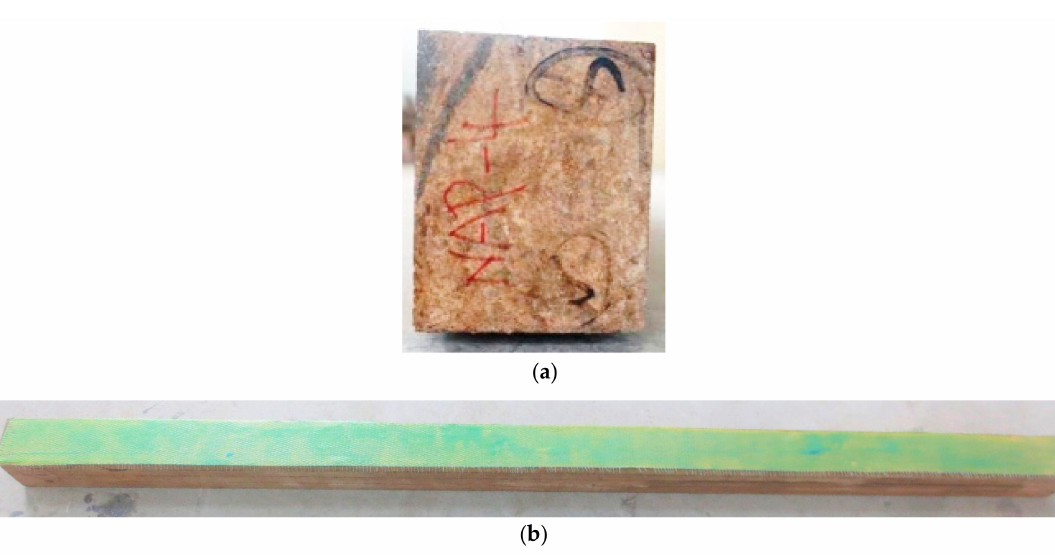
Figure 1. Parallel bamboo beam specimens. ( a ) is the cross section; ( b ) is the bottom of specimen with